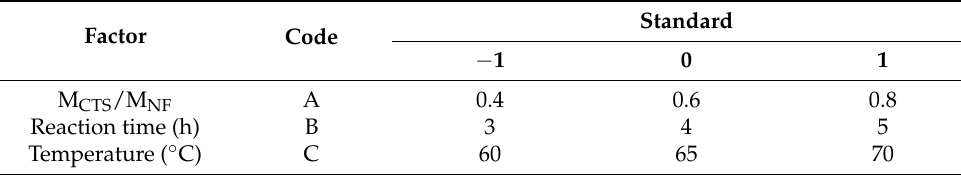
Table 1. Factors and levels of the response surface analysis.